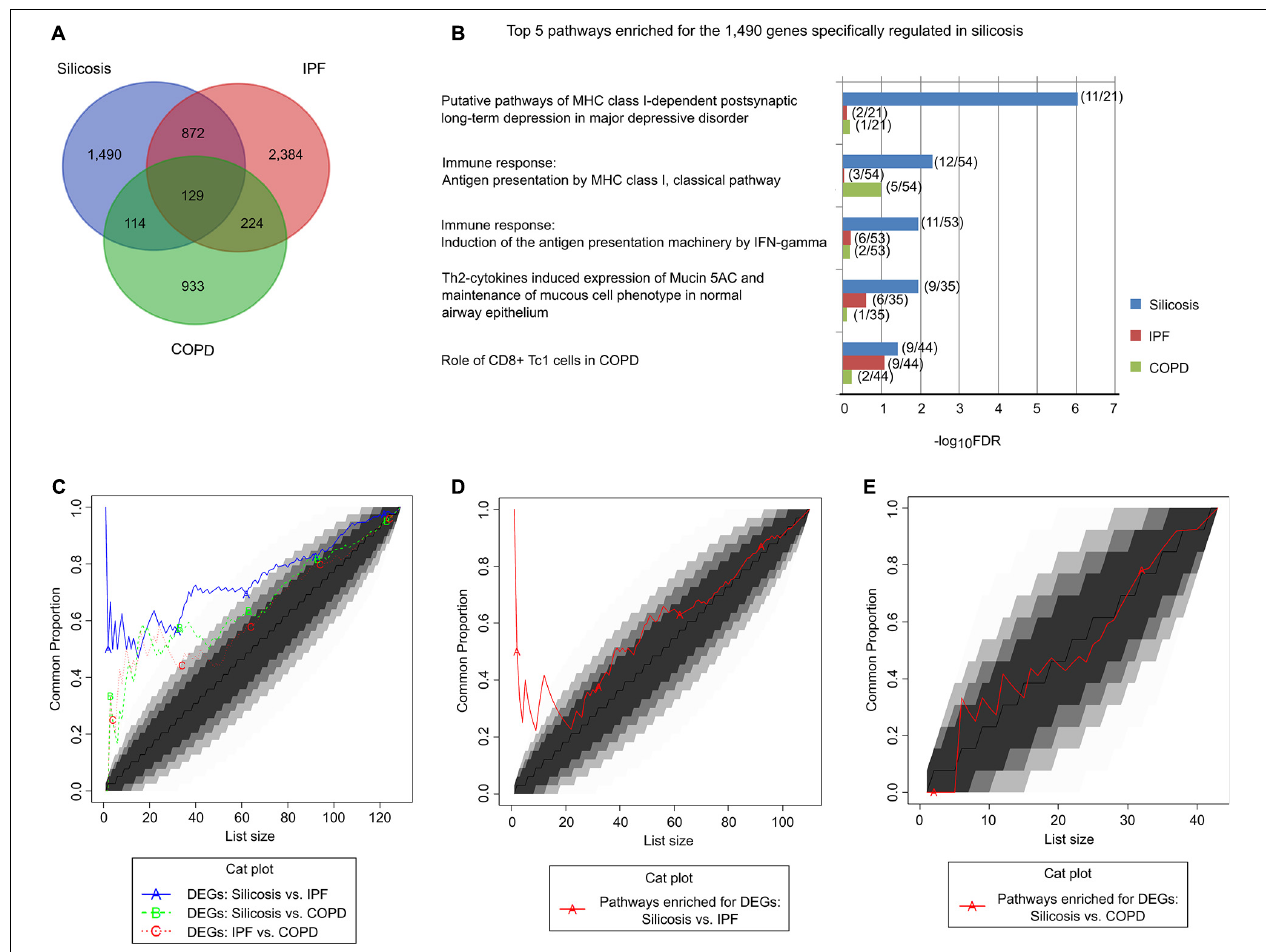
FIGURE 3 | Comparison of the significantly altered genes and their pathways in silicosis, IPF, and COPD. (A) Venn diagram of the significantly altered genes in silicosis, IPF, and COPD. (B) The top 5 pathways enriched for the 1,490 genes exclusively regulated in silicosis. The enrichment results of the corresponding pathways in IPF and COPD are given for comparison. For each pathway the gene count of the differentially expressed genes compared to the total gene counts are given in parentheses. (C) CAT plot of the common DEGs shared among silicosis, IPF, and COPD. (D) CAT plot of the common significant pathways enriched for the DEGs in silicosis and IPF. (E) CAT plot of the common significant pathways enriched for the DEGs in silicosis and COPD.